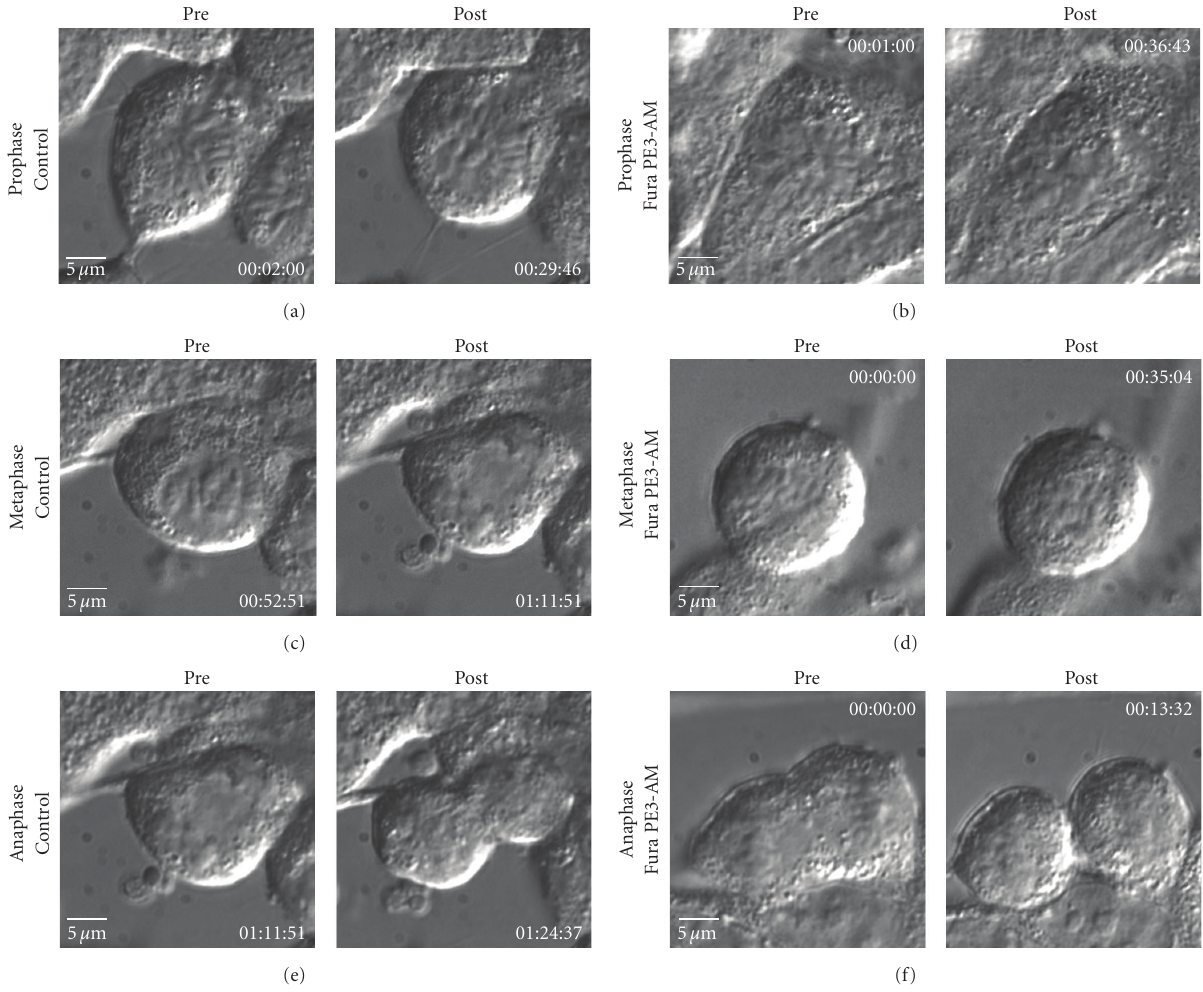
Figure 3: Calcium chelation with fura PE3/AM interrupts specific stages of mitosis . Addition of Fura PE3/AM (4 μ M) results in a cessation and/or regression of mitotic stages prophase (b) and metaphase (d). However, progression from anaphase to cytokinesis is una ff ected (f). (a), (c) and (e) are controls for comparison; images are captured at 30-second intervals as described in Methods; times for these images are as indicated in lower right of each panel. In the control cell (a) prometaphase proceeds to metaphase within 51 minutes and continues to cytokinesis within 1 minute 18 seconds. In contrast, in the Fura PE3/AM-treated prometaphase cell (b), chromosomes decondense and no mitotic progression is seen in > 60 minutes. Similarly, in the presence of Fura PE3/AM, metaphase cells show chromosomes aligned but do not progress in > 30 minutes (d). In the presence of Fura PE3/AM, anaphase progresses normally to cytokinesis